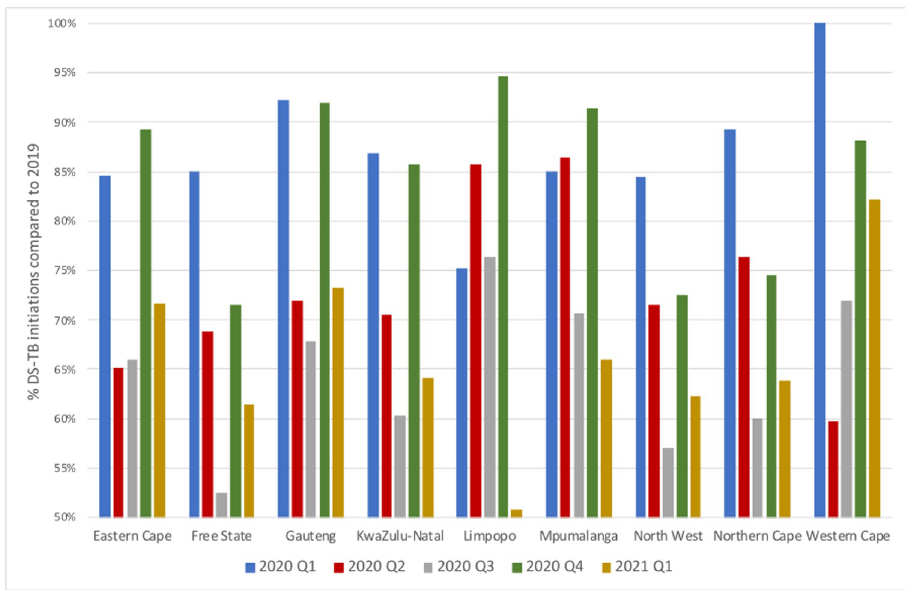
Fig 2. TB treatment initiations in 2020 as a percentage of the number of initiations in 2019, by province.